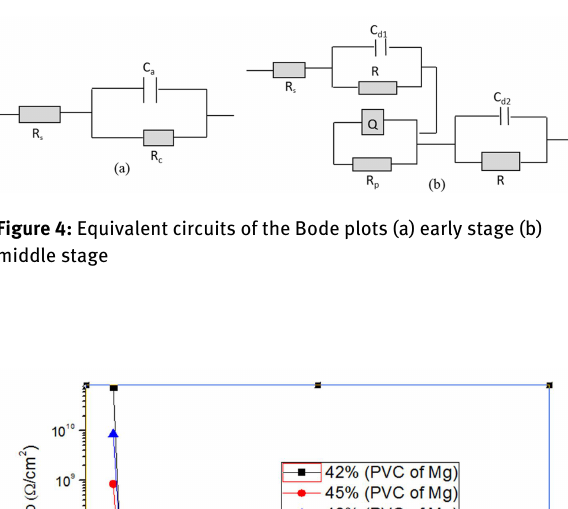
Figure 3: Electrochemical test of the coatings (a) Bode plots at dif- ferent immersing time (b) Tafel polarization curve after immersing 1500 hr